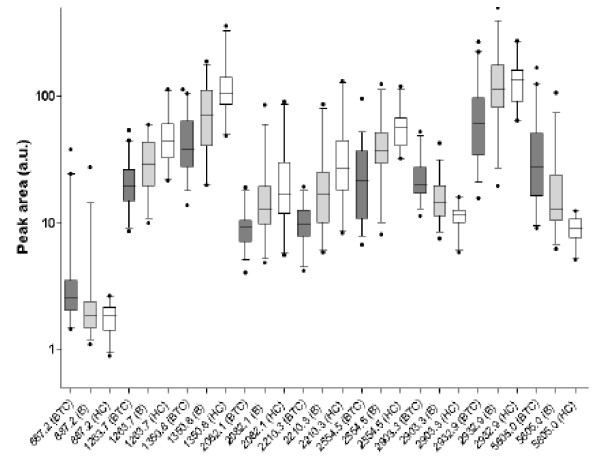
Peaks discriminatory for BTC versus benign biliary disease and healthy controls. Box-and-whisker plots of peak area (5–95 percentile) are shown for differential peptide peaks for biliary tract cancer BTC; dark grey), benign disease (B; light grey) and healthy control (HC; white) samples.